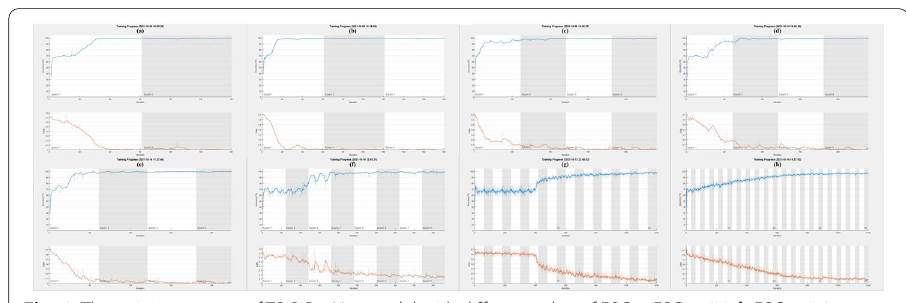
Fig. 6 The training process of TS-BiResNet model with different value of ESC. a ESC ESC 0.4, d ESC =